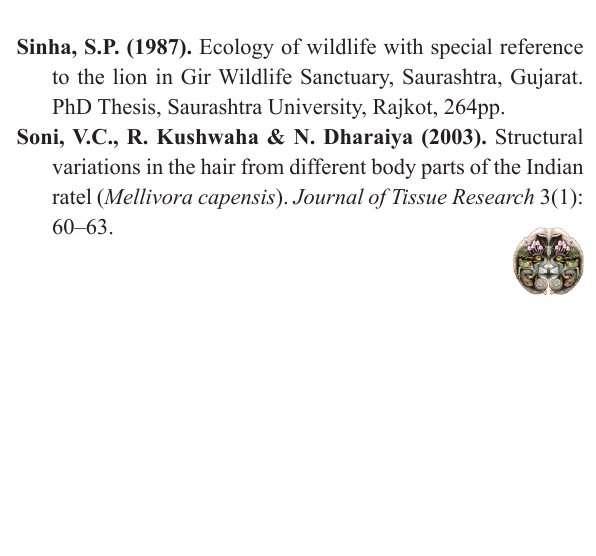
Image 11. Cross section of hair of Asiatic Lion